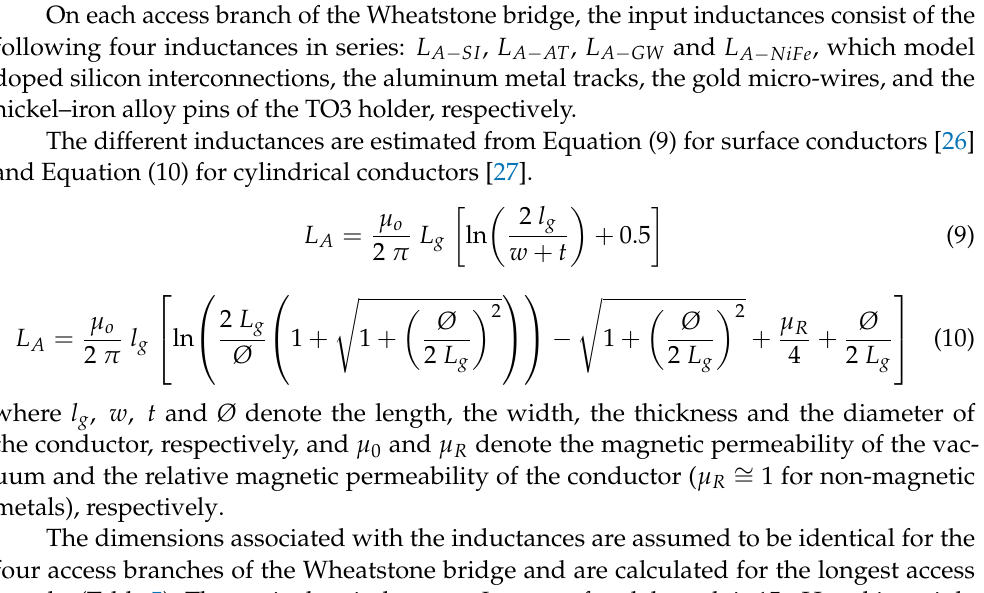
Figure 17. Electrical model of variable resistance implemented in ADS software (example for R G 2 gauge).